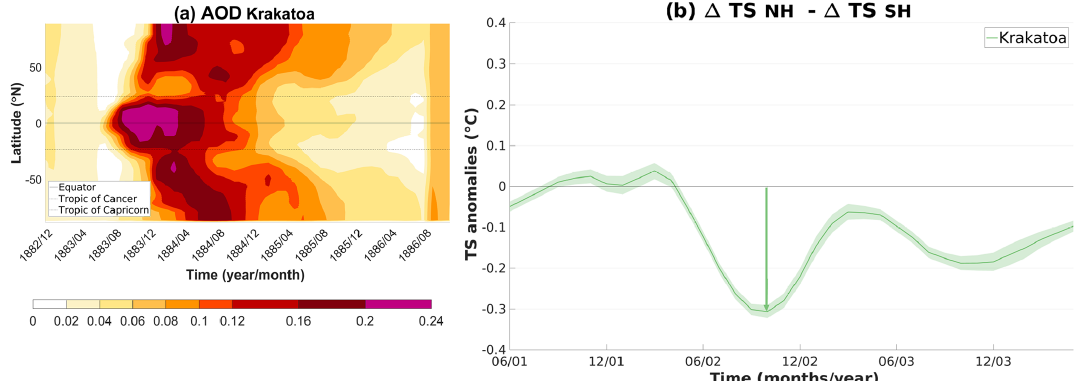
Figure A6. Evolution of the aerosol optical depth and ensemble average of the difference between the cooling of the SH ( (cid:49)T SH) and the NH ( (cid:49)T NH) for the Krakatau eruption. (a) The band of wavelength used is between approximatively 462 and 625nm. (b) The 3- year climatology is subtracted to calculate the anomalies. Shading represents twice the standard error of the ensemble mean (i.e. ∼ 95% confidence